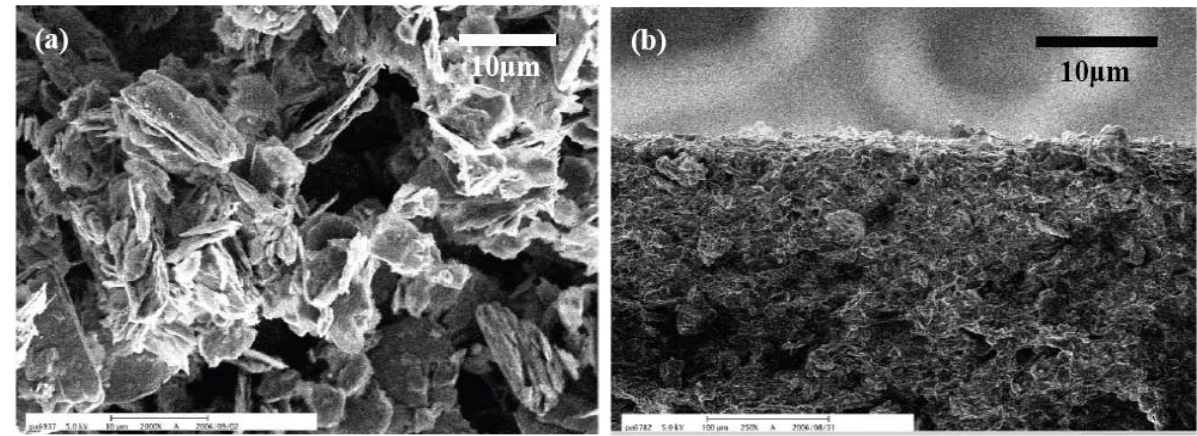
Figure 1. SEM images of (a) graphite powder and (b) a graphite-PDMS